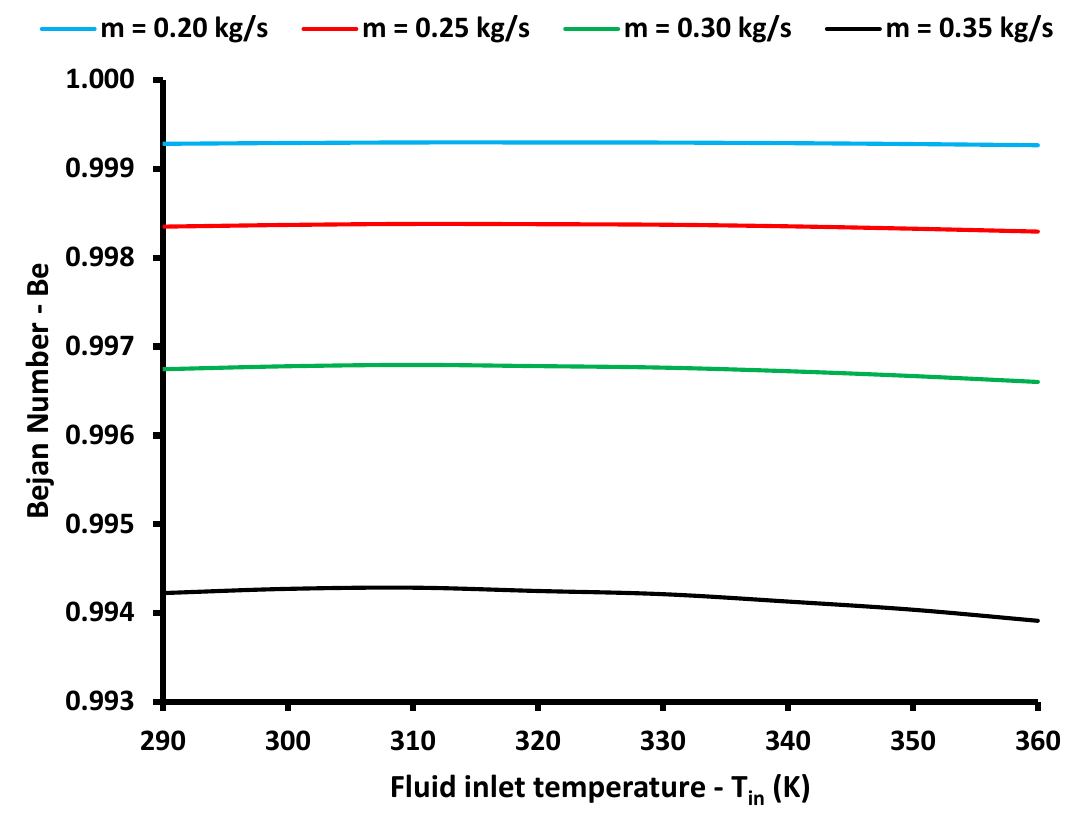
Figure 12. Bejan number variation for the different operating scenarios in the reference case of the empty tube.